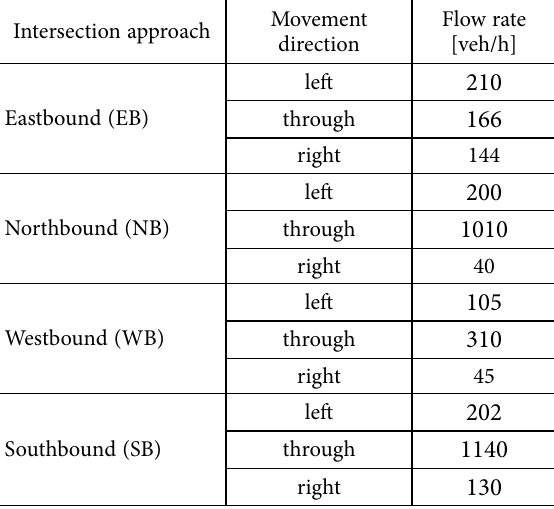
Table 3. Basic traffic flow rate